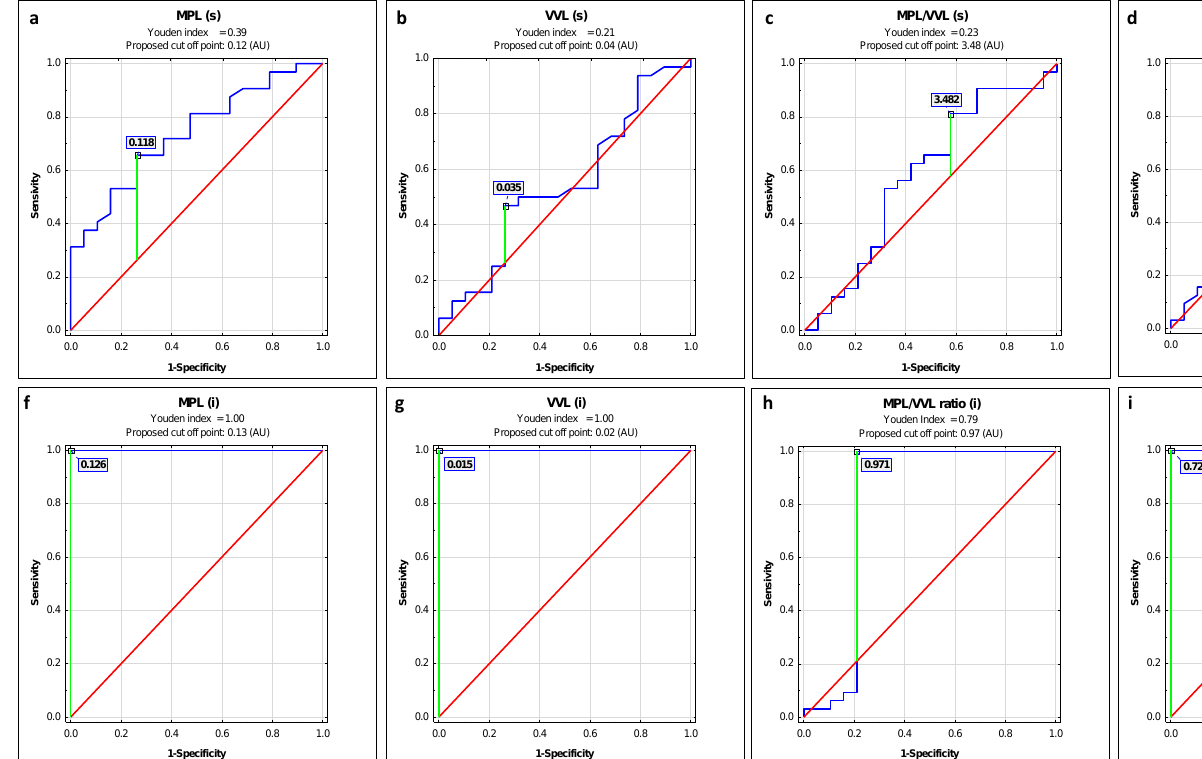
Figure 4. ROC curve analysis of s-IgG and i-IgG glycans’ relative reactivities with lectins for non-endometriosis women and healthy subjects ( a – j ). The reference line is marked in red, the receiver operating characteristics for the parameter in blue, and the cut-off point in green, MPL— Maclura pomifera lectin, VVL— Vicia villosa lectin, MPL/VVL—O-glycosylation ratio, Jacalin— Artocarpus integrifolia lectin and PHA-L— Phaseolus vulgaris leucoagglutinin. For specificity of lectins see Materials and Methods section.